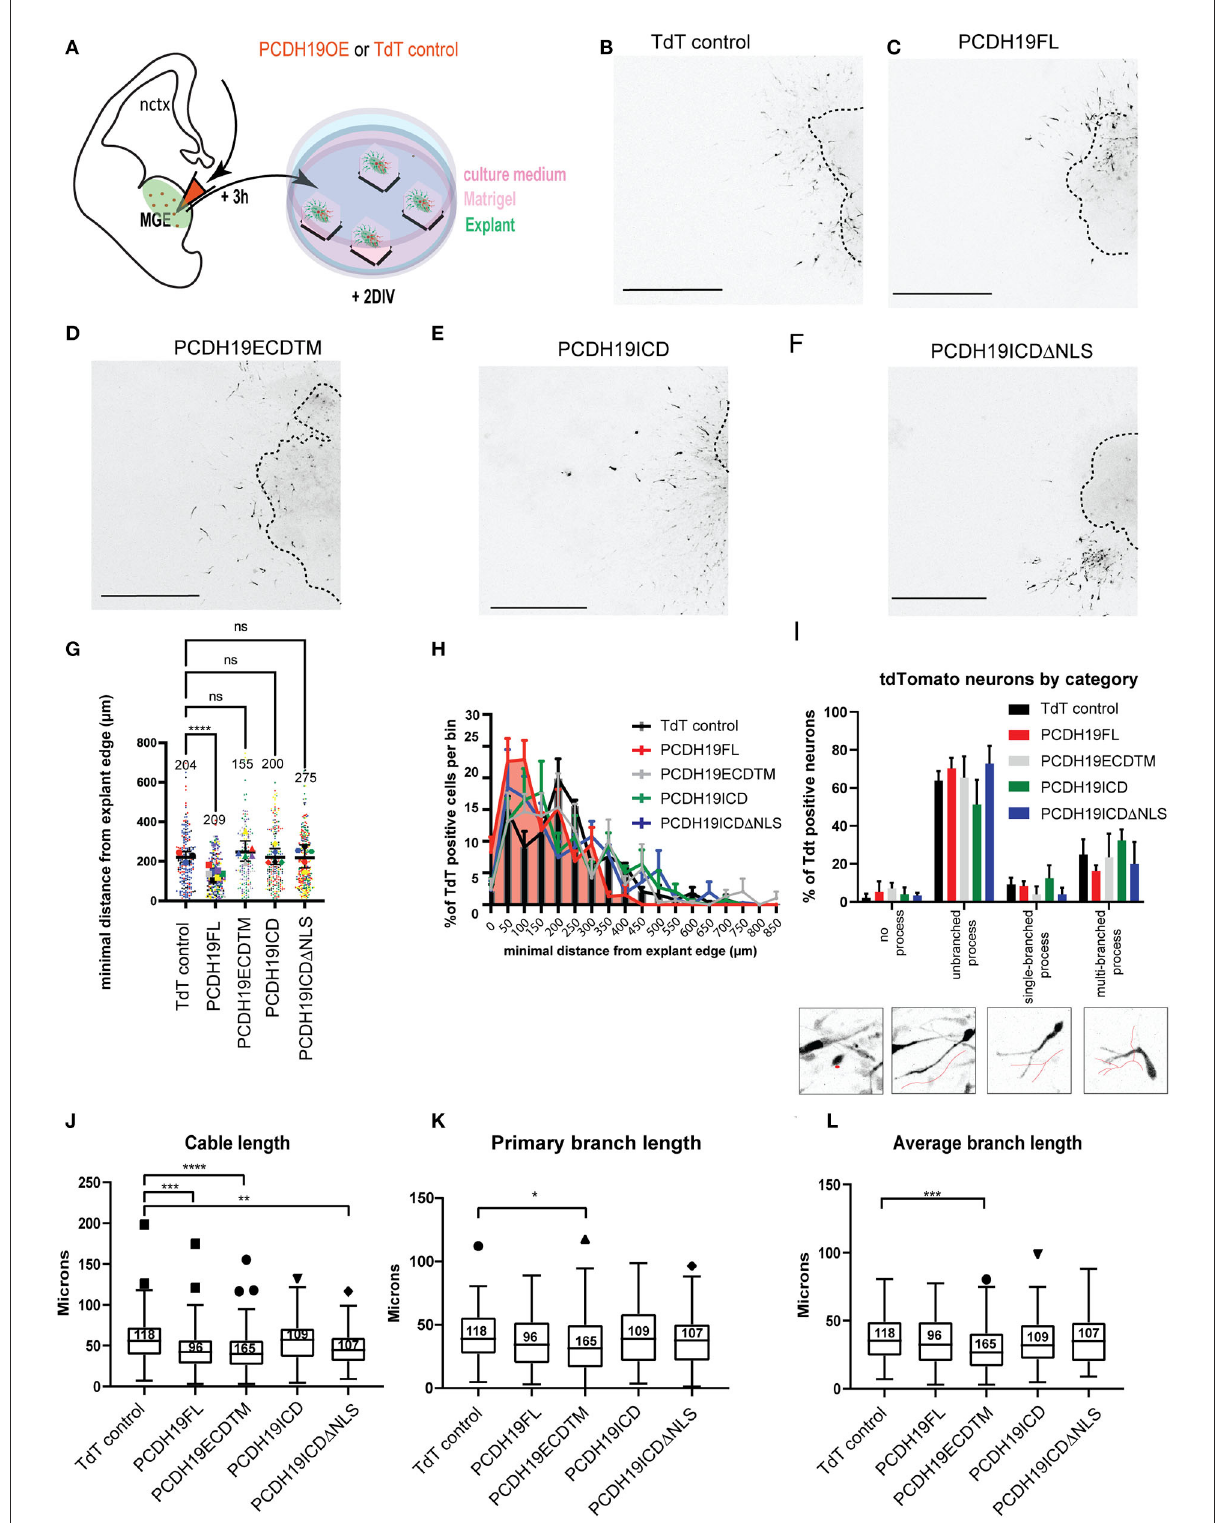
FIGURE4 Effects of overexpressing PCDH19 subdomains on MGE cell migration and morphology. (A) A schematic of the ex vivo MGE explant electroporation setup to investigate the effect of PCDH19 overexpression in MGE-derived IN. Total minimum migration distance ‘d’